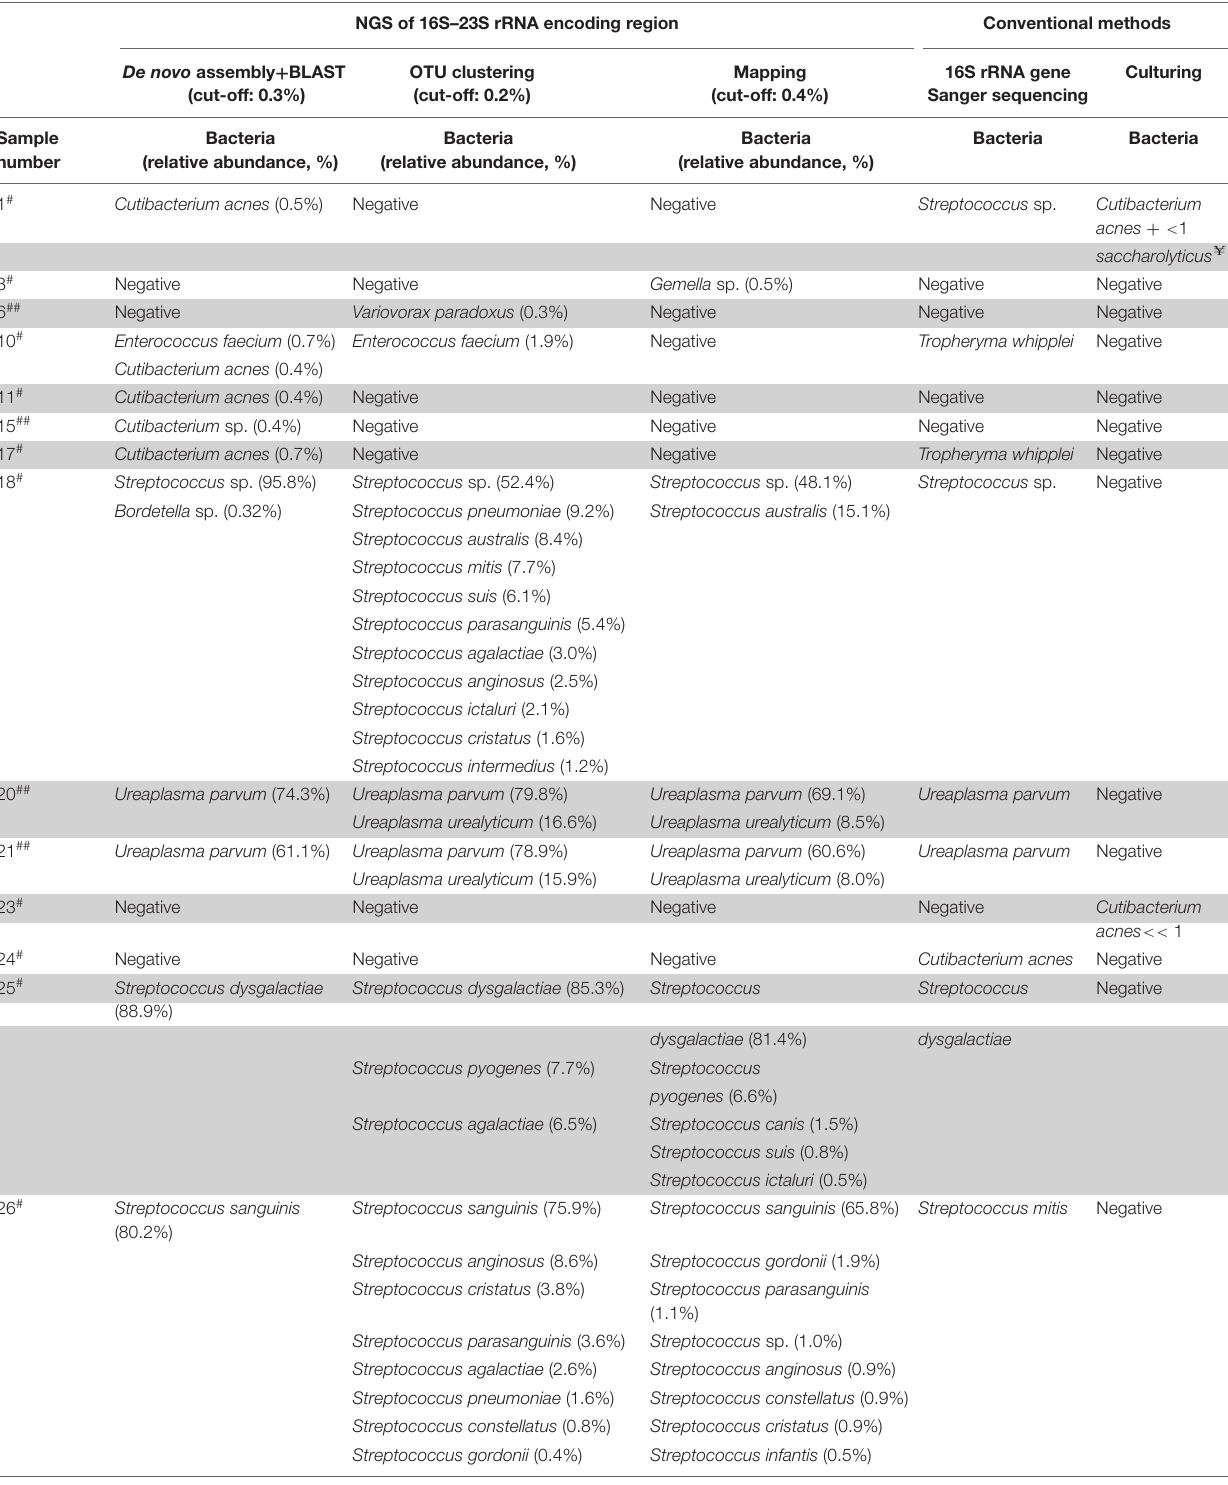
TABLE 2 | Bacterial species identified by NGS of 16S–23S rRNA encoding region using three different data analysis approaches and 16S rRNA gene Sanger sequencing and culturing. NGS of 16S–23S rRNA encoding